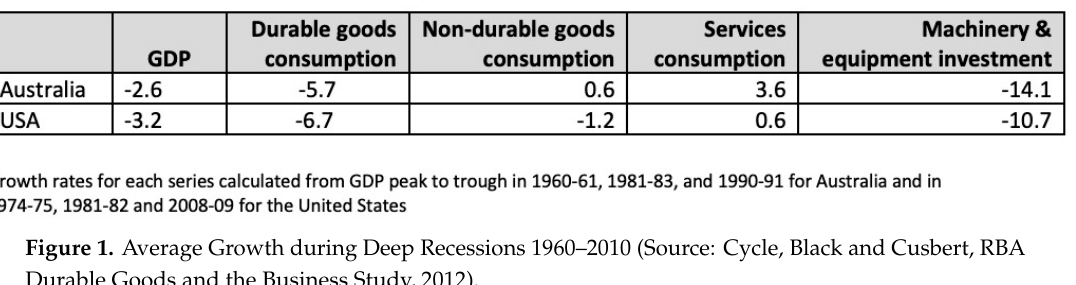
Figure 1. Average Growth during Deep Recessions 1960–2010 (Source: Cycle, Black and Cusbert, RBA Durable Goods and the Business Study,